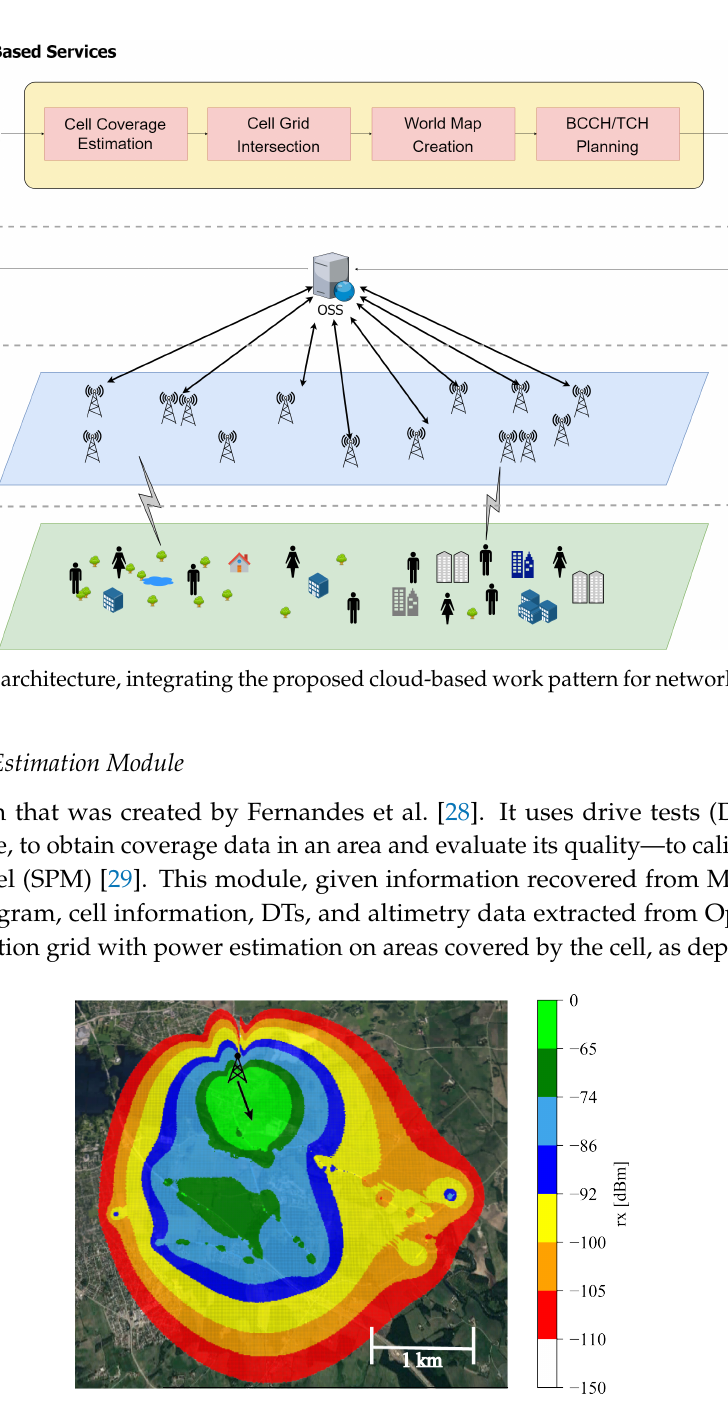
Figure 8. Representation of the antenna’s received signal level estimation, calibrated with drive